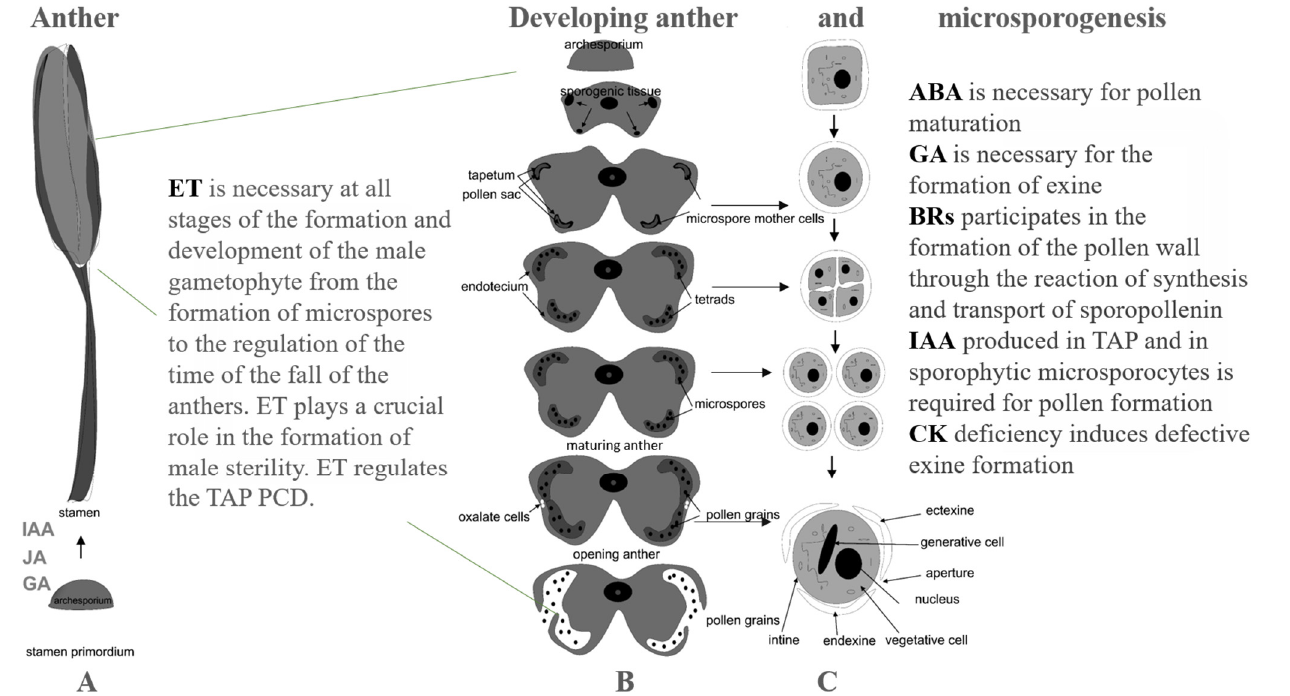
Figure 1. Scheme of microsporogenesis and anther development and the role of phytohormones at different stages. Stamen development ( A ). Anther development ( B ). Pollen formation ( C ).